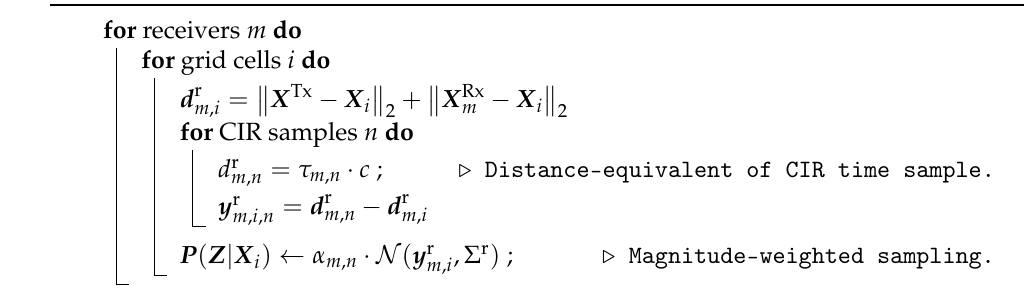
Algorithm 1: Probability Grid Mapping—Likelihood